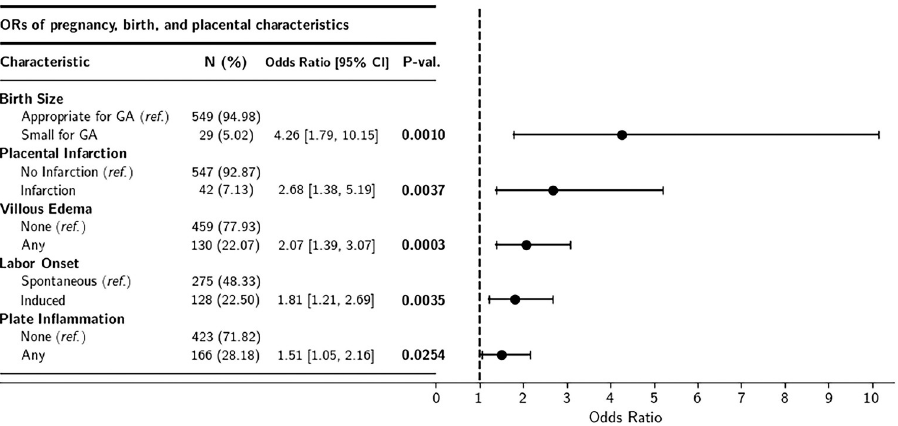
Fig 4. Association of TIs, birth outcomes, and placental pathologies. Forest plot of unadjusted odds ratios for identification of placental trophoblast inclusions across pregnancy, birth, and placental pathology findings.